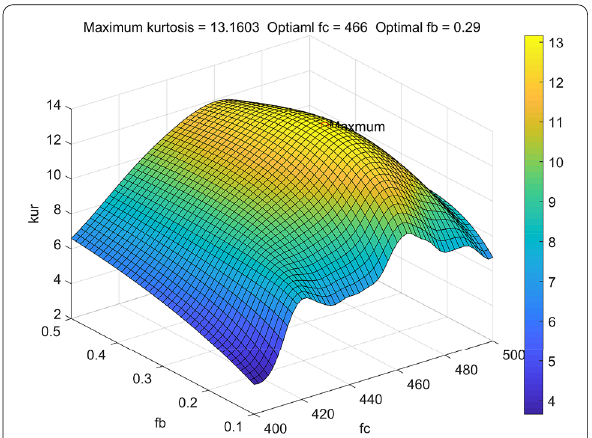
impulse. From Figure 24, the fault characteristic fre-